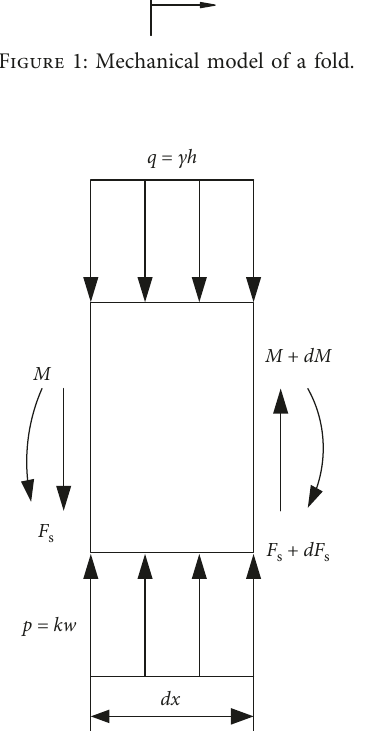
Figure 2: Stress analysis diagram of the anticlinal microsection dx